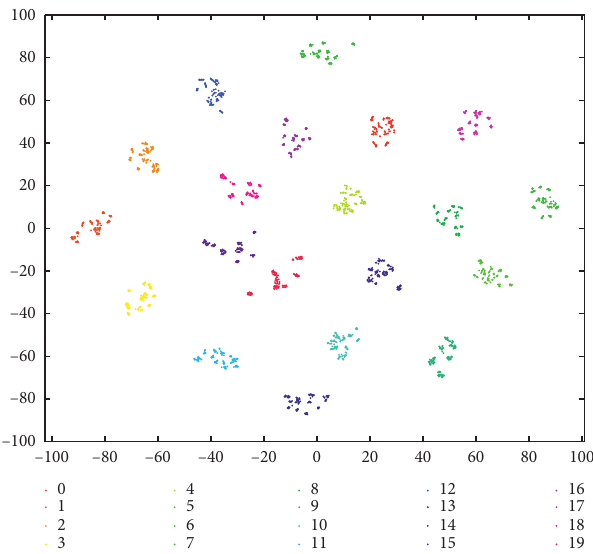
Figure 15: The t-SNE visualization of the overall feature extraction of